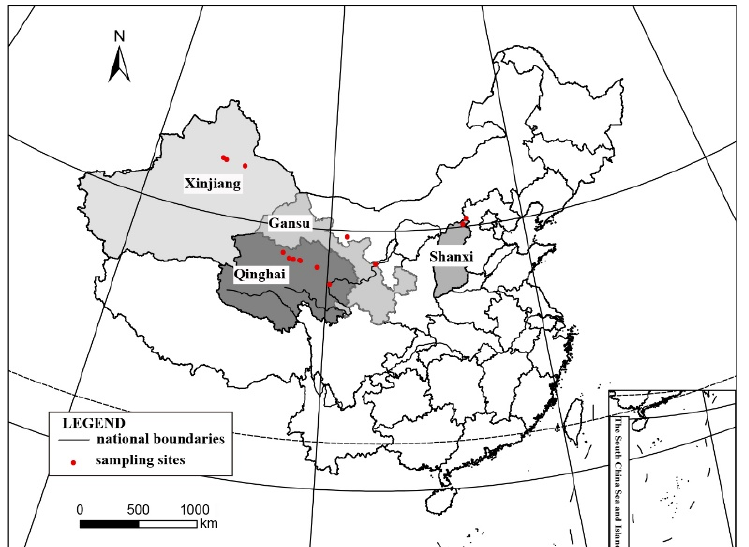
Figure 1. Collection sites. The detailed collection areas are marked in a solid red circle, and the corresponding four provinces involved are marked with varying degrees of a gray color.